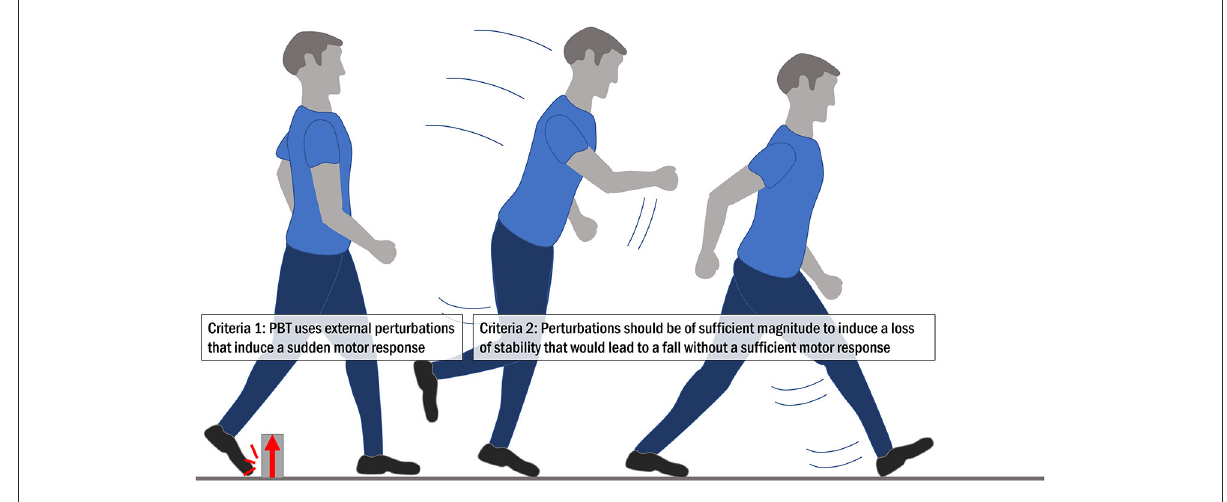
FIGURE1 The two key criteria for perturbation-based balance